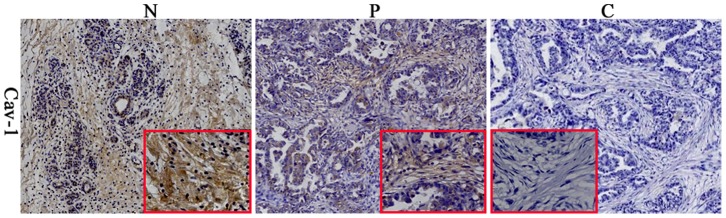
Representative immunohistochemistry results of stromal Cav-1 expression in pancreatic tissue.Paraffin sections were immunostained as described in the methods section. (N) Normal tissue strongly positive for Cav-1 expression; (P) Paracancer tissue moderate for Cav-1 expression; (C) Tumor tissue with negative Cav-1 expression (×400).